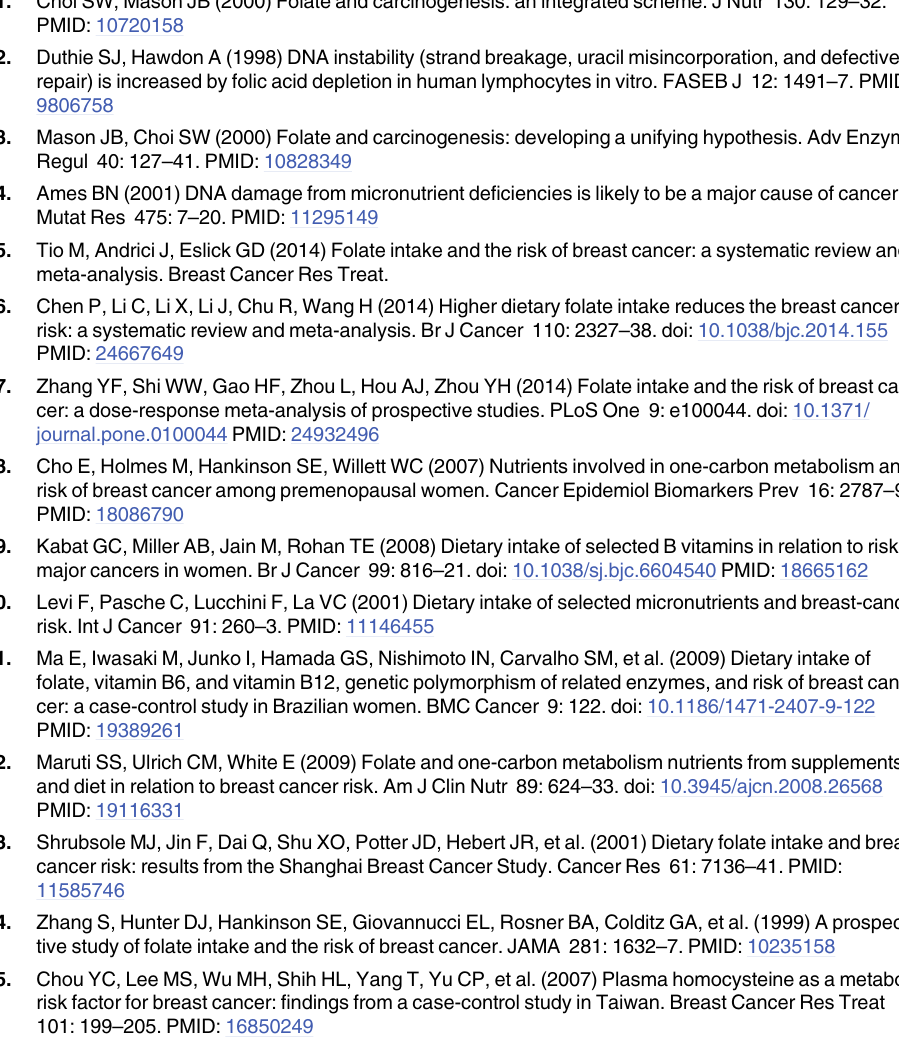
S3 Table. HRs (95% CIs) of breast cancer in relation to quartiles of folate intake in ORDET women, stratified by alcohol